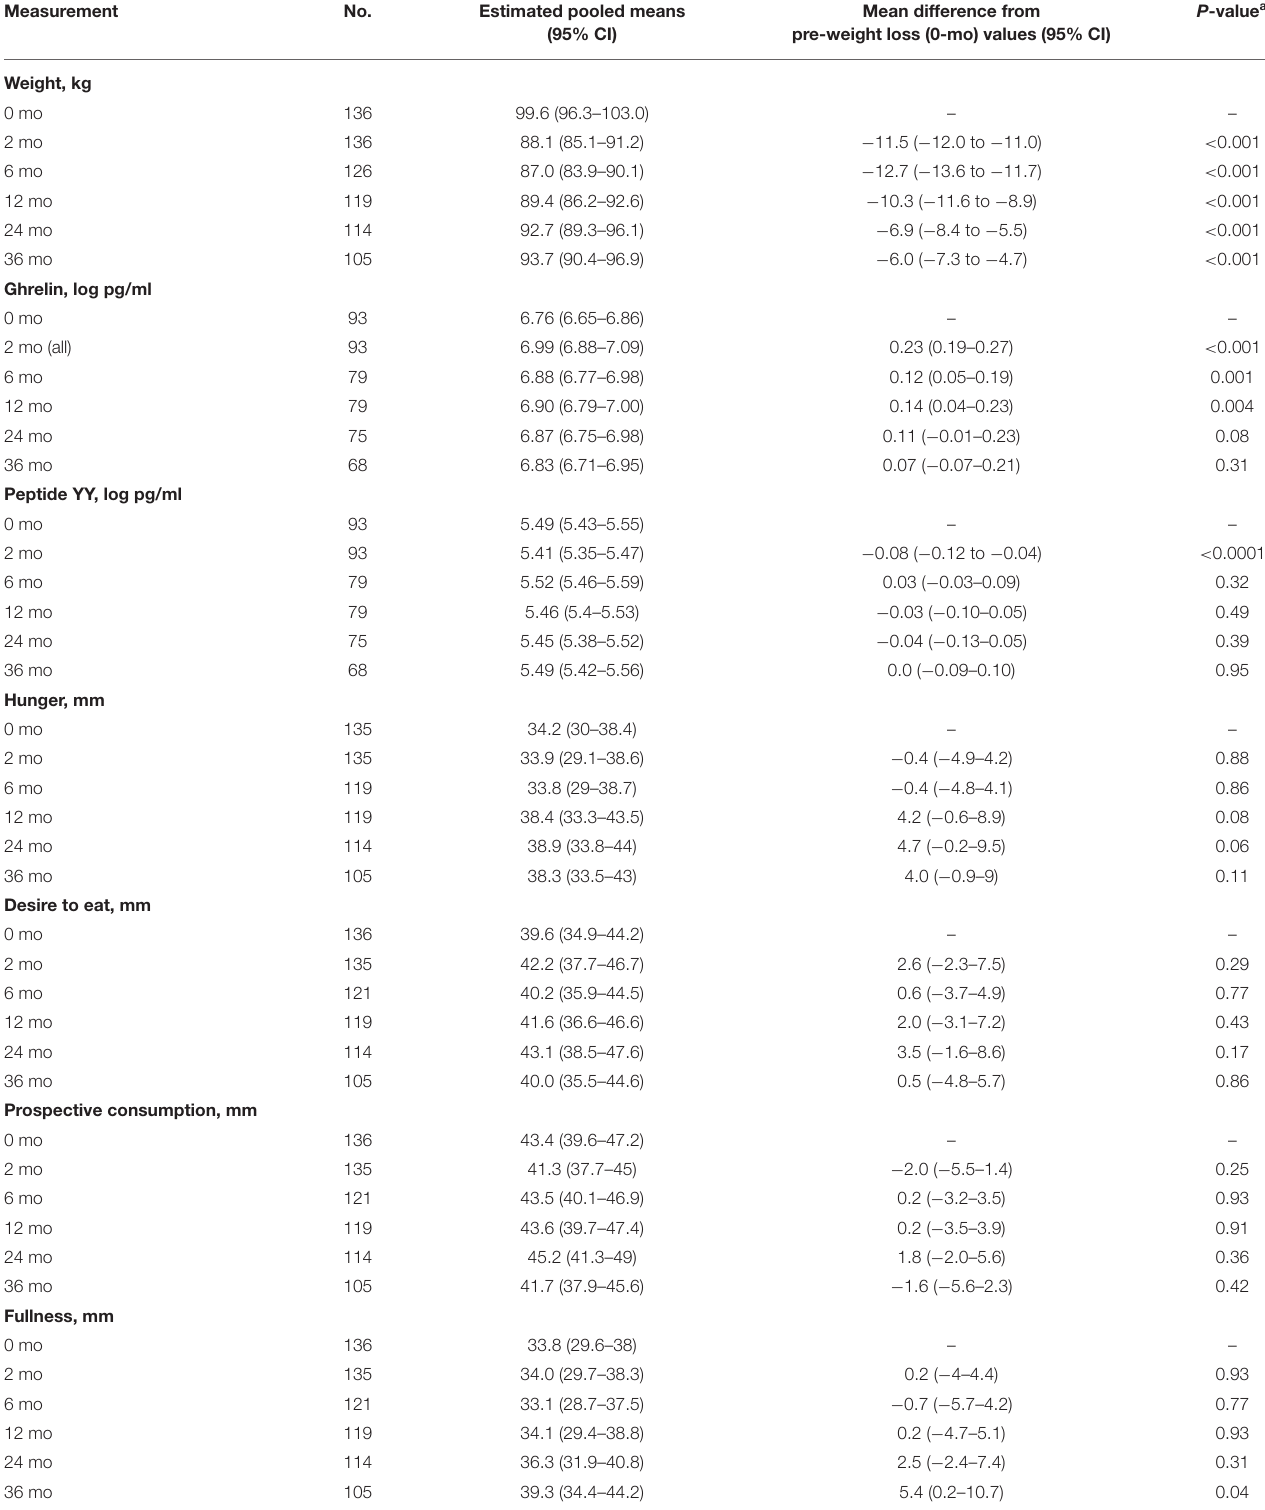
TABLE 3 | Body weight, plasma gut hormone concentration and fasting appetite sensations of participants in both groups, pooled into a single group.